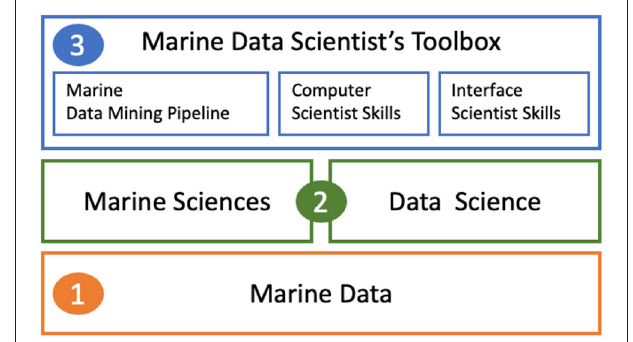
FIGURE 1 | Elements of Marine Data Science. The object of MDS research is marine data (1). Knowledge involved in MDS bases on the parental sciences, Marine and Data Sciences (2). Key methods of MDS are collected in the Marine Data Scientist’s Toolbox (3). This includes the Marine Data Mining Pipeline as well as Computer and Interface Scientist